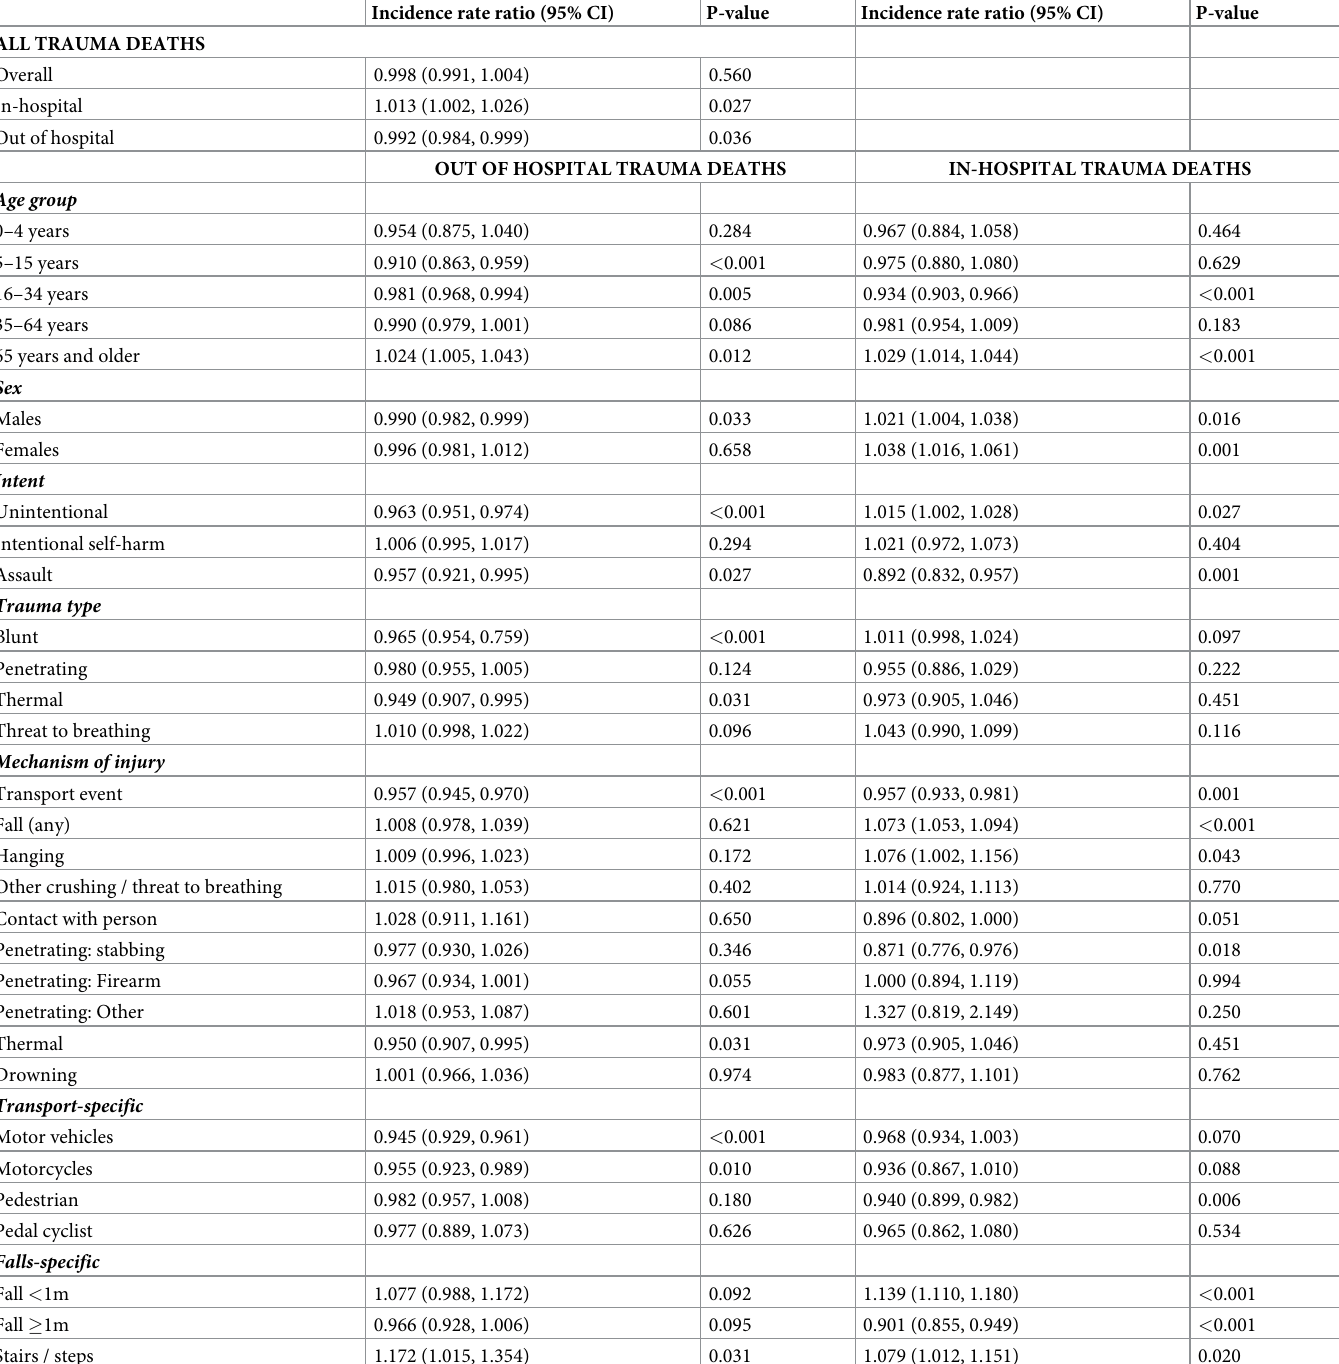
Table 2. Temporal trends in incidence over the period of 1 July 2006 to 30 June